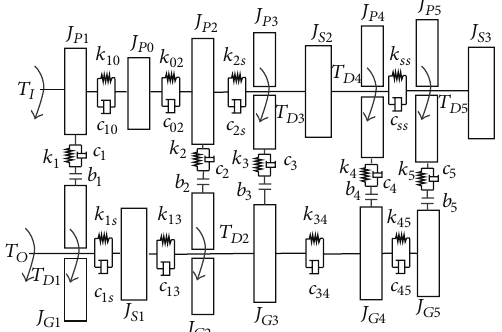
Figure 9: Equivalent physical model of 5-speed MT.